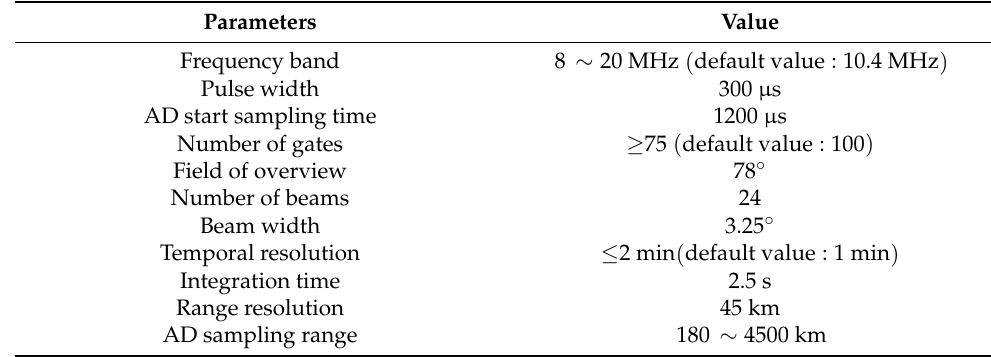
Table 1. AgileDARN working parameters in normal observation